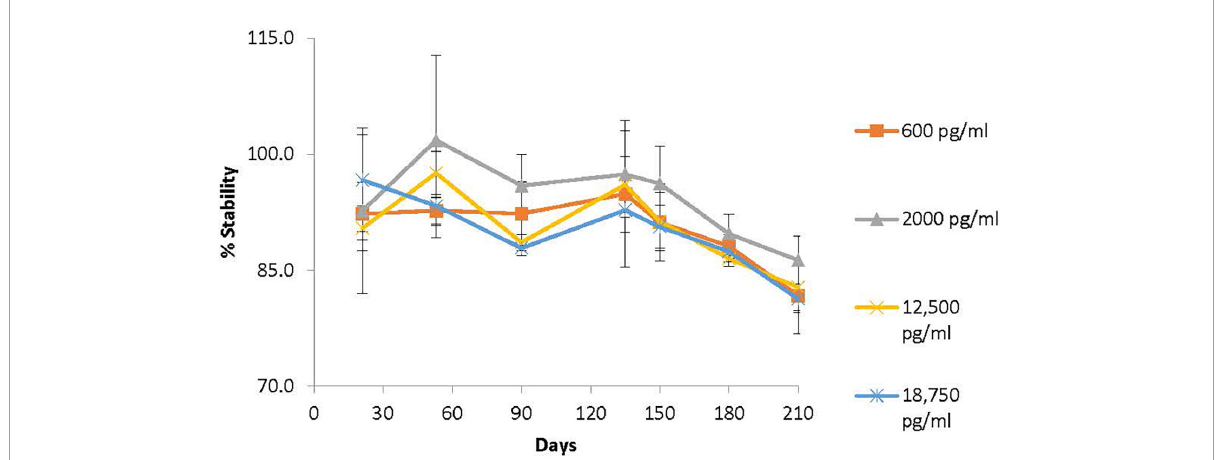
FIGURE8 Division of applied regulatory science (DARS) developed and validated novel, sensitive, and specific analytical methods to support pediatric pharmacokinetic studies using dried blood spot (DBS) cards. One such method was for methylphenidate, an attention-deficit hyperactivity disorder drug. The long-term stability profile of methylphenidate on DBS cards stored for up to 7 months at room temperature (64) is shown. Methylphenidate was found to be stable ( ± 15% of spiked concentration) on DBS cards stored at 24 ◦ C for up to 5 months.